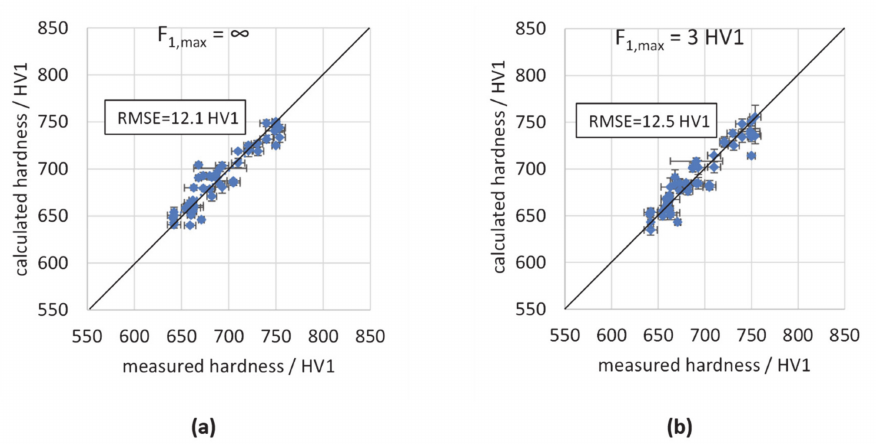
Figure 7. Correlation of micromagnetic determined and actual measured hardness of the calibration data set without limitation of the maximum error effect ( a ) and with limitation to 3 HV1 ( b ).